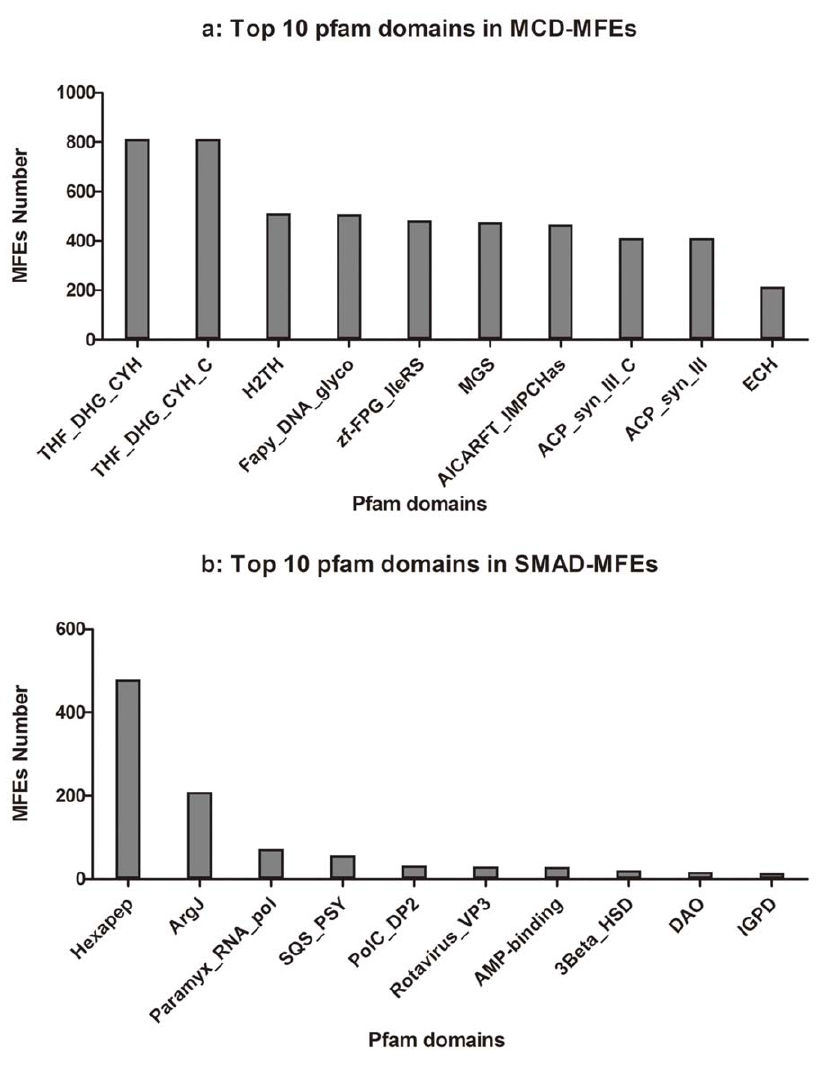
Figure 1. The top 10 frequently used Pfam domain families for known MFEs. It is noted that about 17% of SMAD-MFEs contain ArgJ. It plays key role in both N-acetylglutamate synthase and ornithine acetyltransferase activities in the cyclic version of arginine biosynthesis.